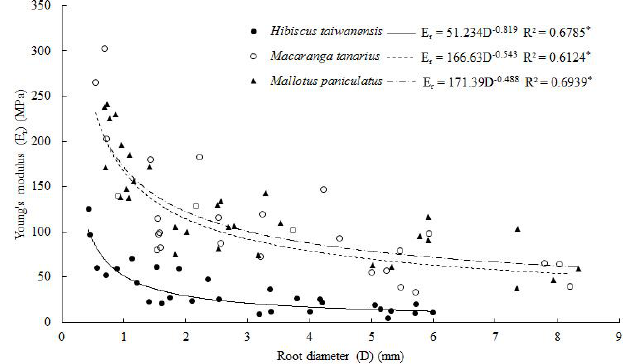
Figure 6. Relationship between Young’s modulus and root diameter for the three species studied.